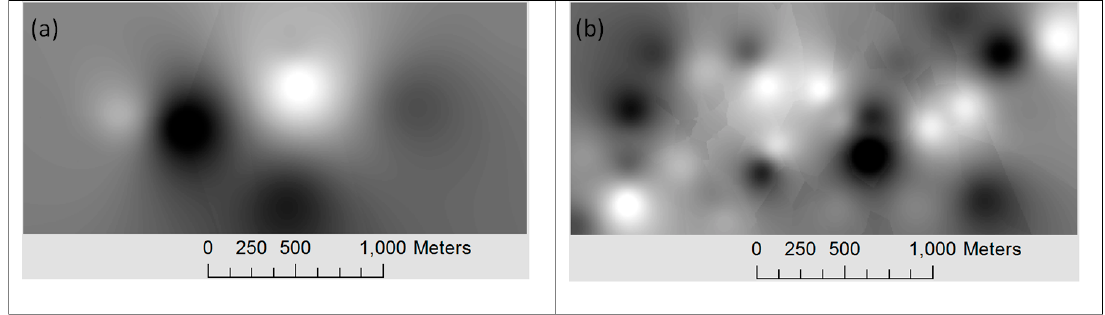
Figure 9. Raster layers from people’s opinions in experiment 1 for ( a ) legibility; and ( b ) permeability.